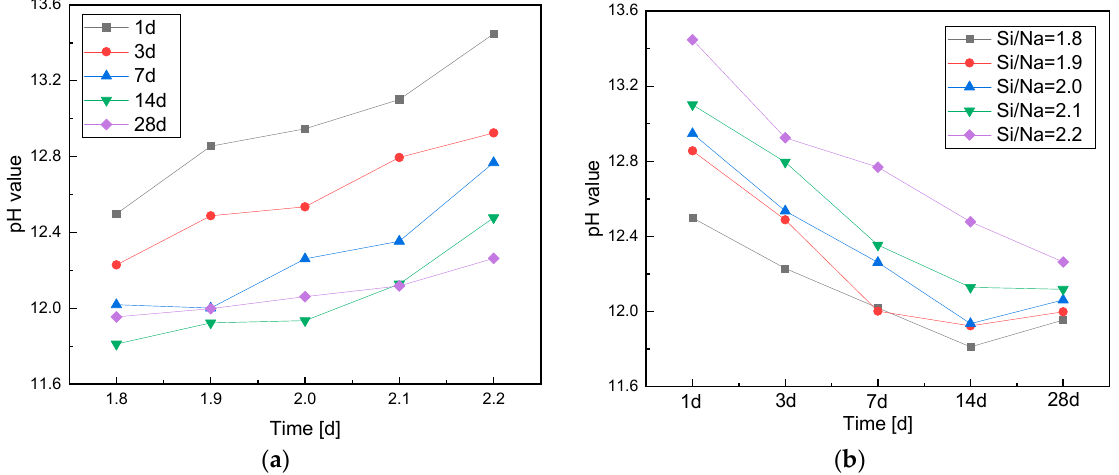
Figure 3. ( a ) A chart of the changes in the pH of the pore solutions with Si/Na ratio; ( b ) a chart of the changes in the pH of the pore solutions with